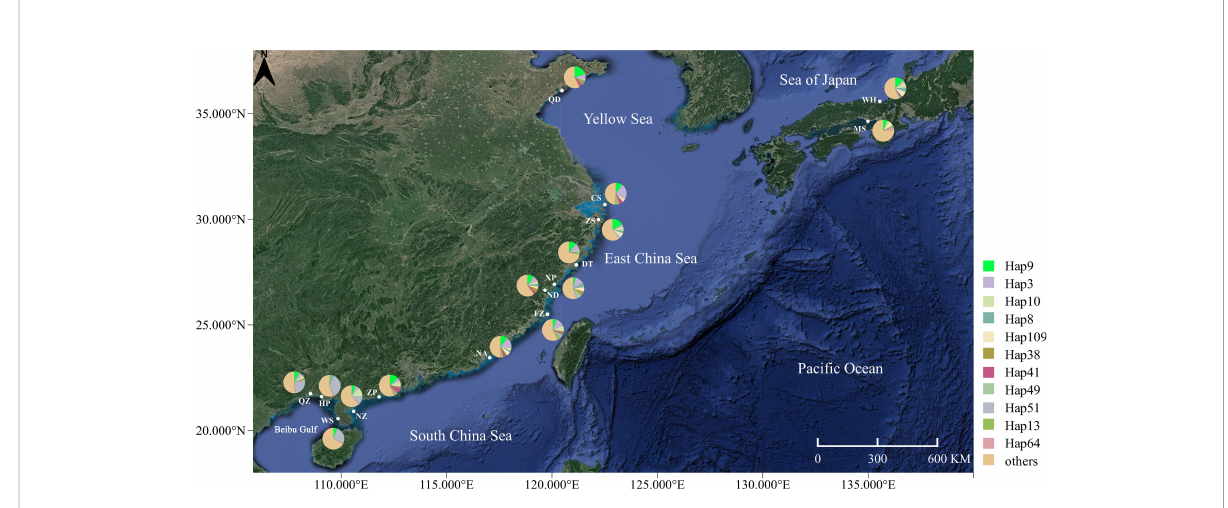
FIGURE 1 Map of the coastal waters of the China Sea, showing the sampling locations and phylogroup distributions of Sebastiscus marmoratus . The geographical location of the sampling sites in the study area is shown in Table